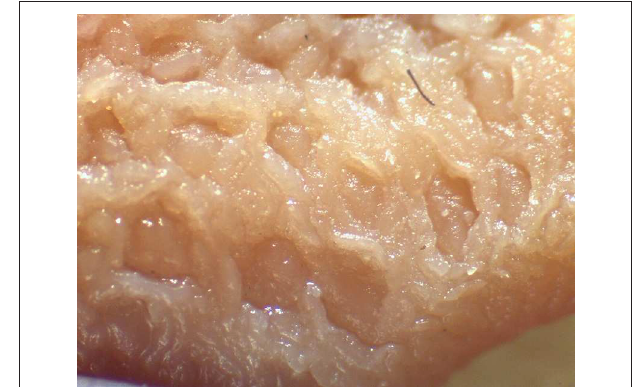
FIGURE 1 | Appearance of the Peyer’s patch in the last 3cm of the terminal ileum of a pig after 48h of fixation in glutaraldehyde 2.5% (v/v). Particular of the mucosa at stereomicroscope 24 ×